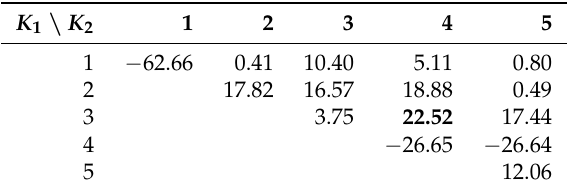
Figure 8. Scatter plots of the crabs data after PCA. Subspecies are represented according to their color, and sex is represented according to its symbol. Table 2. Value of the BIC criterion according to K 1 and K 2 , for the choice of the number of clusters on the crabs dataset, best value in